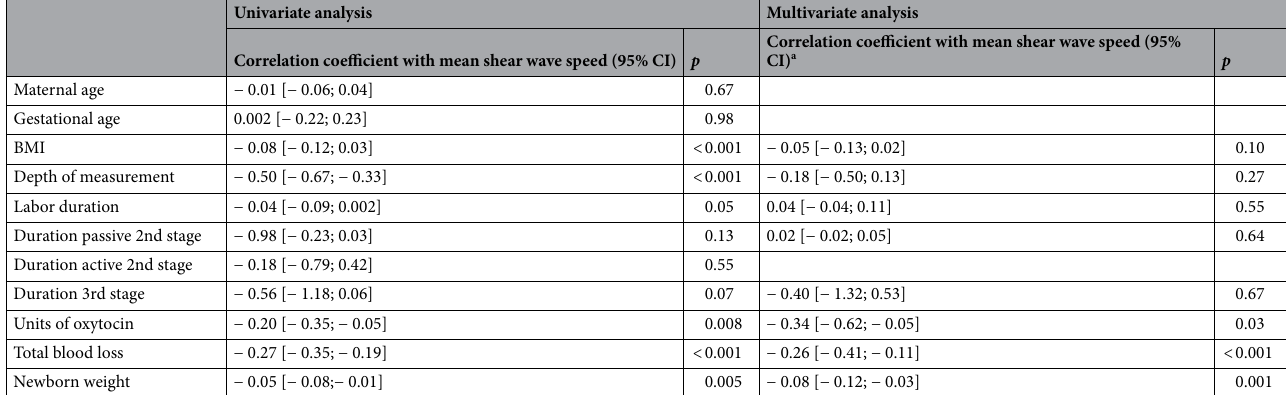
Table 2. Correlation coefficients with mean SWS. BMI body mass index, CI confidence interval. a Adjusted for body mass index, depth of measurement, labor duration, duration passive 2nd stage, duration 3rd stage, units of oxytocin, total blood and newborn